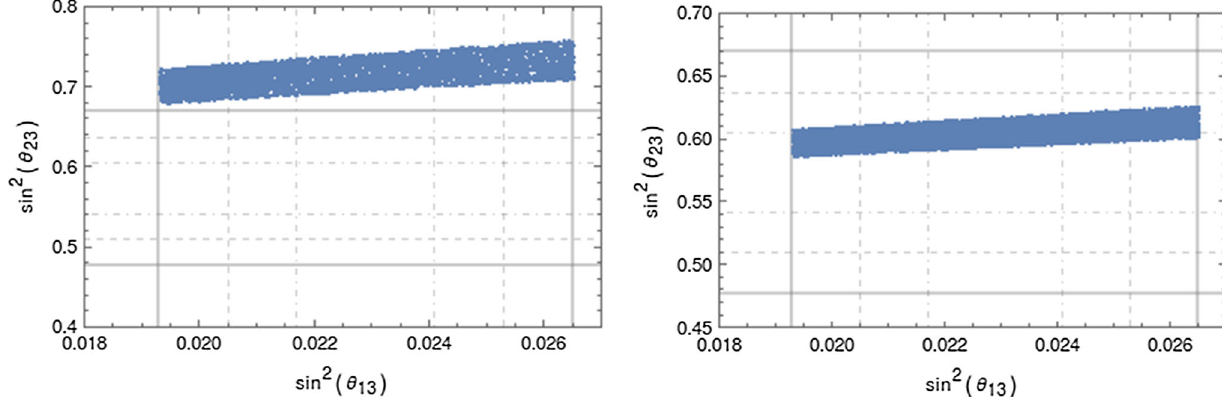
Fig. 3 sin 2 θ 23 versus sin 2 θ 13 . The left and right panels stand for the Case C and Case D , respectively. The dot-dashed , dashed and thick lines stand for 1 σ , 2 σ and 3 σ of C. L., respectively for each case